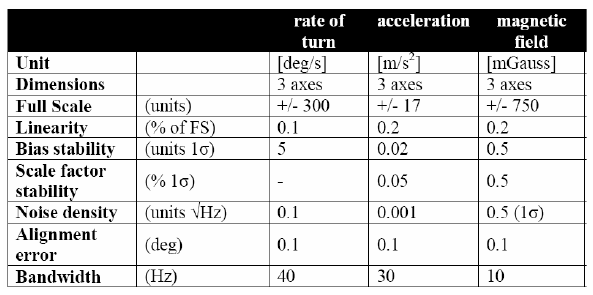
Table 1. Xsens IMU characteristics